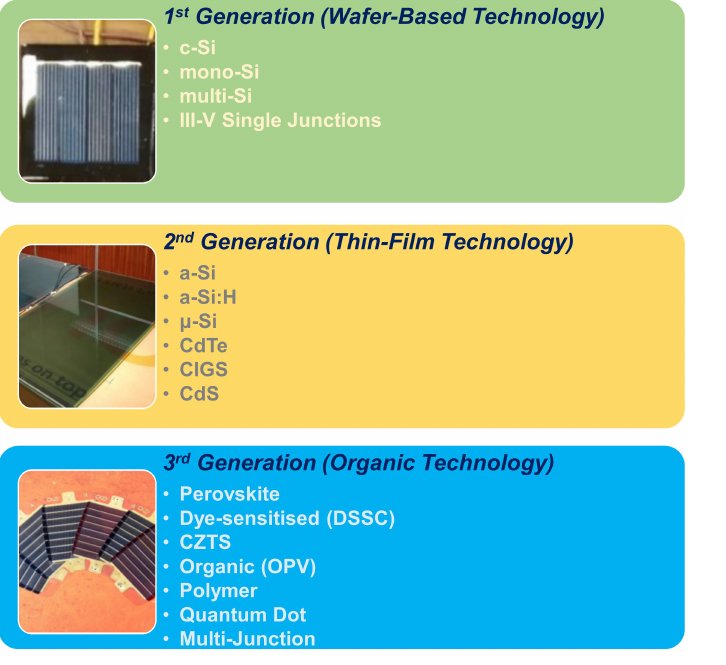
Figure 1. Categorisation of photovoltaic